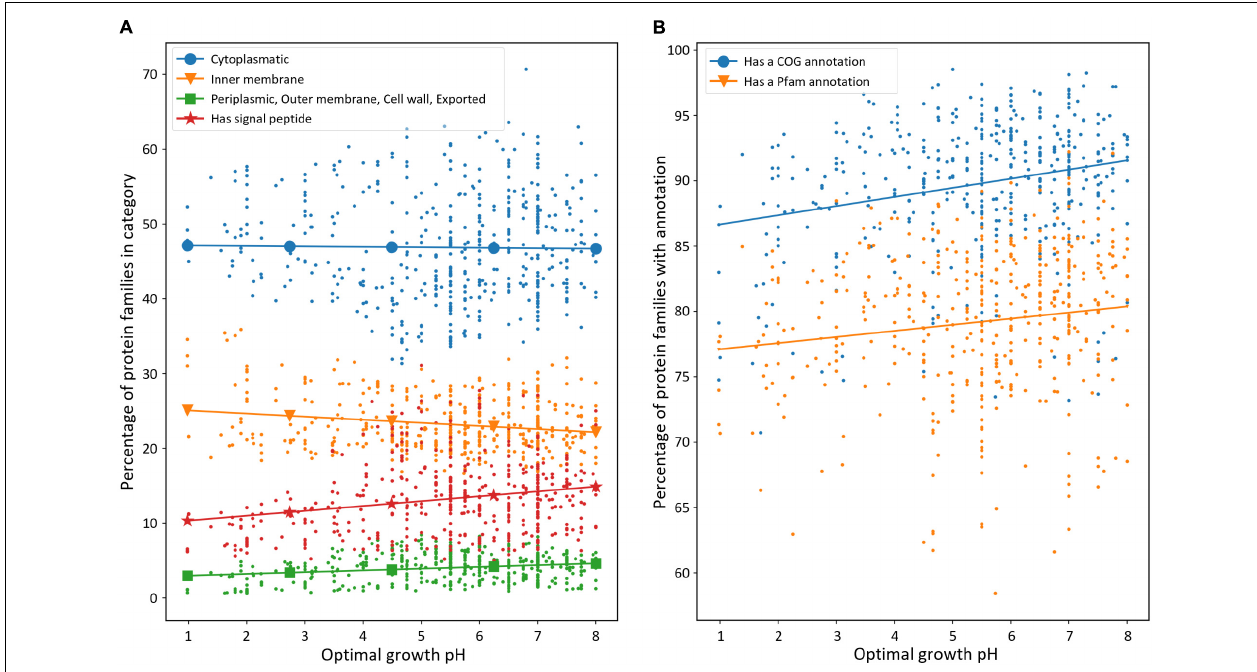
FIGURE 7 | Distribution of protein families across pH. Each point corresponds to a species. (A) Subcellular localization and signal peptide presence of protein families across pH. PSORTb and SignalP were used to predict the subcellular location of proteins and signal peptide, respectively. Either subcellular localization or signal peptide presence is expressed in terms of percentage of the protein families (ortholog groups). Pearson’s correlation coefficient and p -value, respectively, are − 0.01 and 0.77 for cytoplasmic (blue), − 0.19 and 4.4 × 10 − 5 for inner membrane (orange), 0.21 and 7.5 × 10 − 6 for periplasmic, outer membrane, cell wall, and exported (green), and 0.22 and 1.4 × 10 − 6 for proteins with a signal peptide (red). (B) Percentage of protein families with functional classification across pH. The blue data points and the blue line correspond to proteins with a Clusters of Orthologous Genes (COG) annotation, and the orange data points and the orange line correspond to proteins with a Pfam annotation. Pearson’s correlation coefficients and p -values are, respectively, 0.24 and 2 × 10 − 7 for proteins with a COG annotation and 0.14 and 2.6 × 10 − 3 for proteins with a Pfam